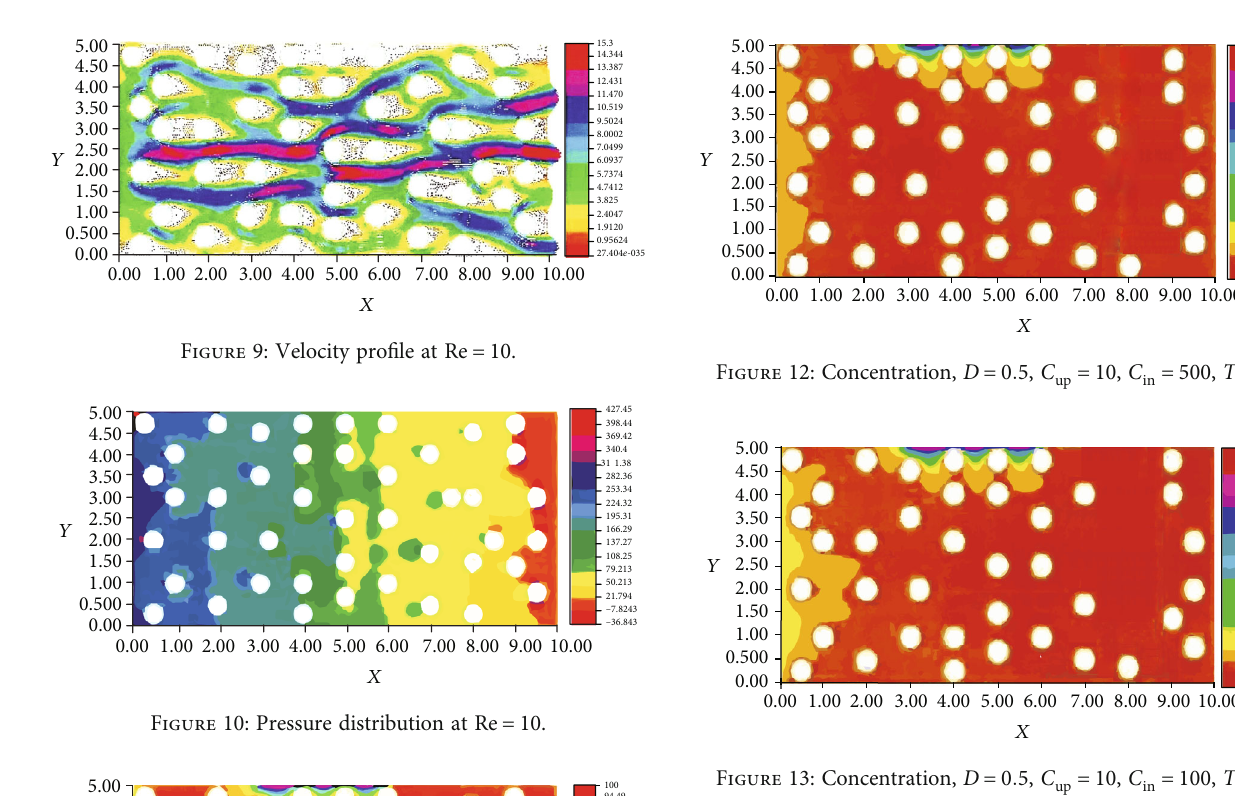
= 10 , C = 100 , T = 5 up in